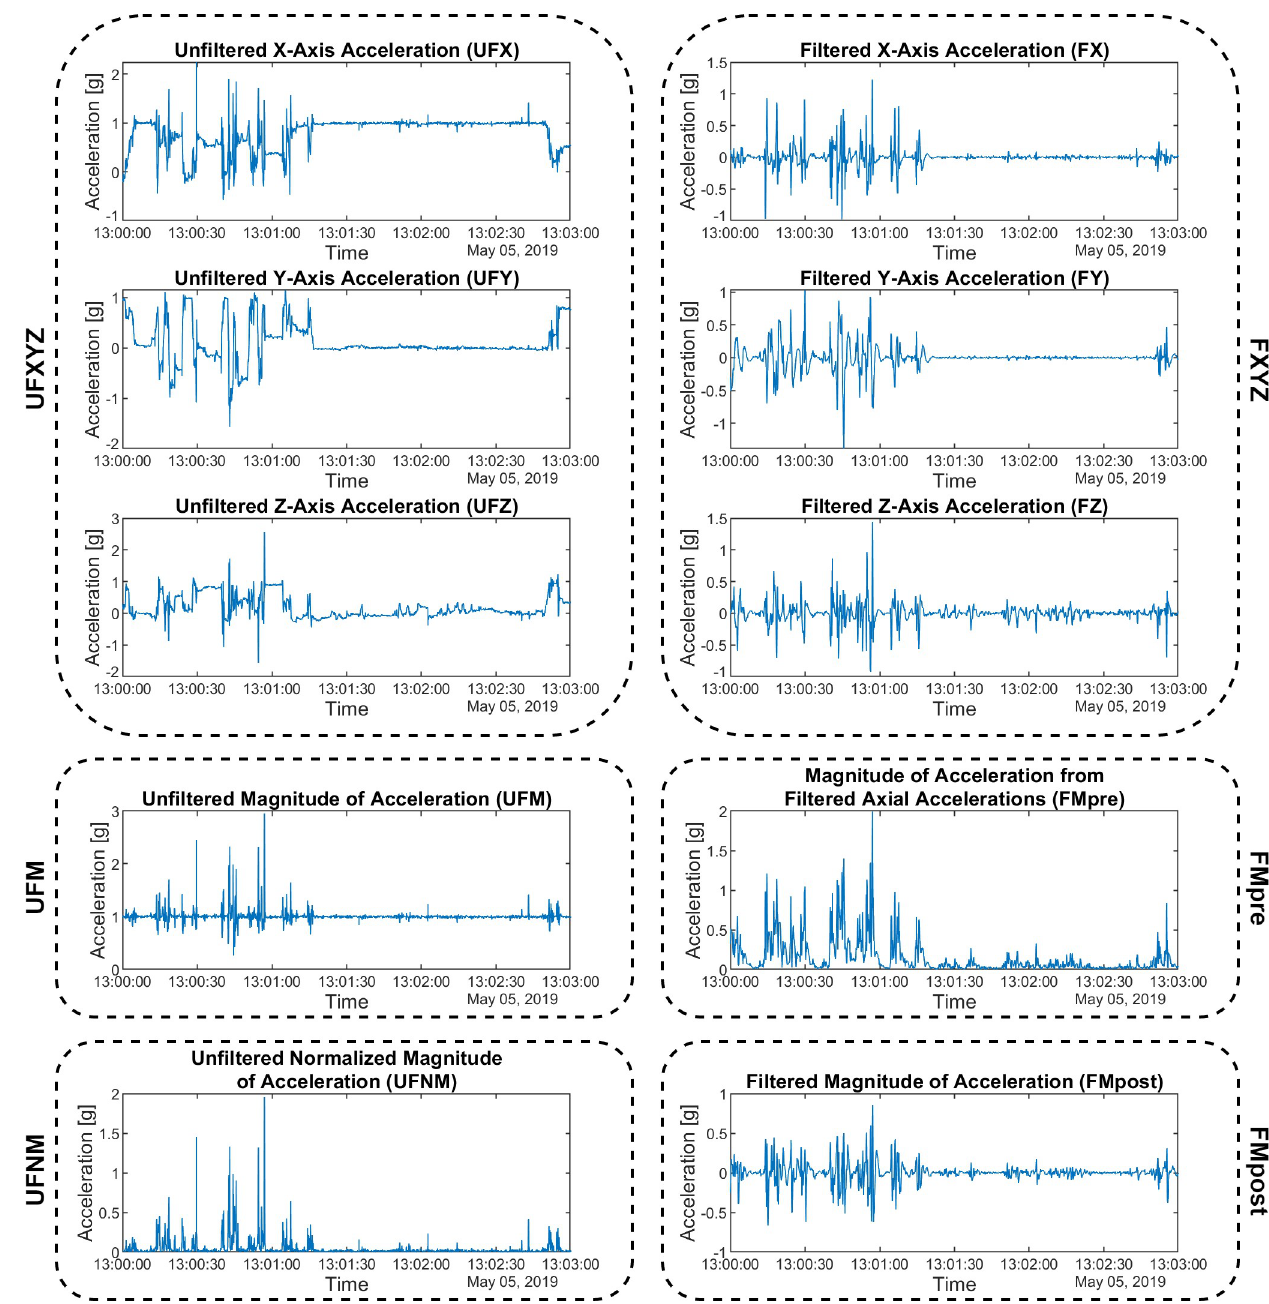
Fig 3. Examples for the 6 different dataset types. UFXYZ and FXYZ datasets are compositions of the axial sub datasets. The waveforms cover the same 3-minute-long section of a subject’s motion.